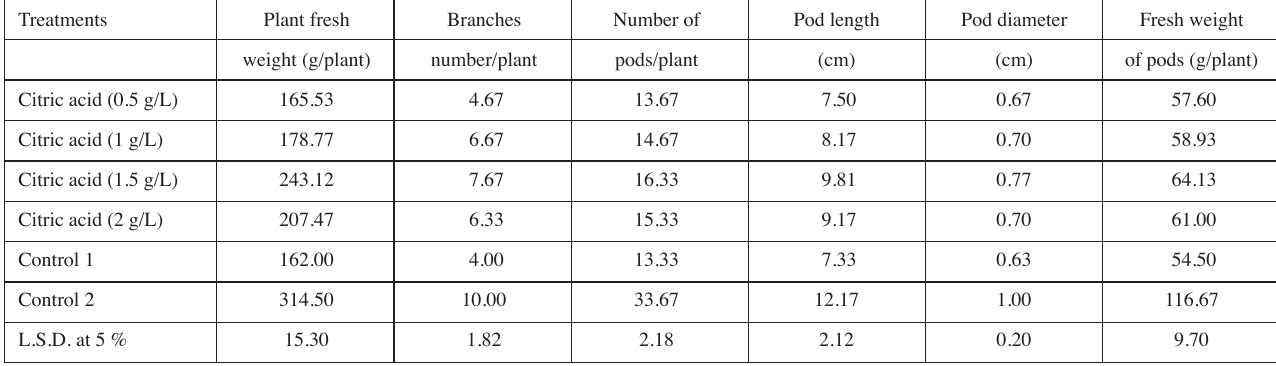
Tab. 1: Effect of different levels of citric acid on vegetative growth, generative productivity and pod characteristics of bean plants subjected to drought stress conditions (first season). Control 1: plants not treated by citric acid, but stressed. Control 2: plants not treated by citric acid and kept at field capacity during the entire